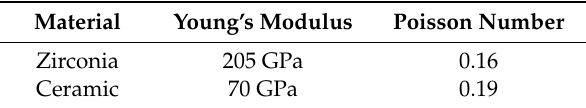
Table 2. The material data for zirconia and ceramic adopted for calculation purposes.